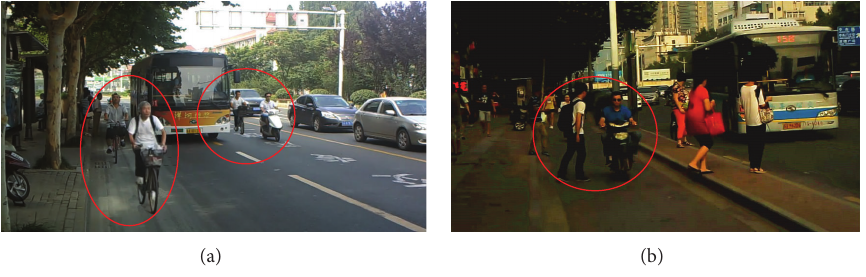
Figure 2: Traffic conflicts near the bus stop in China.